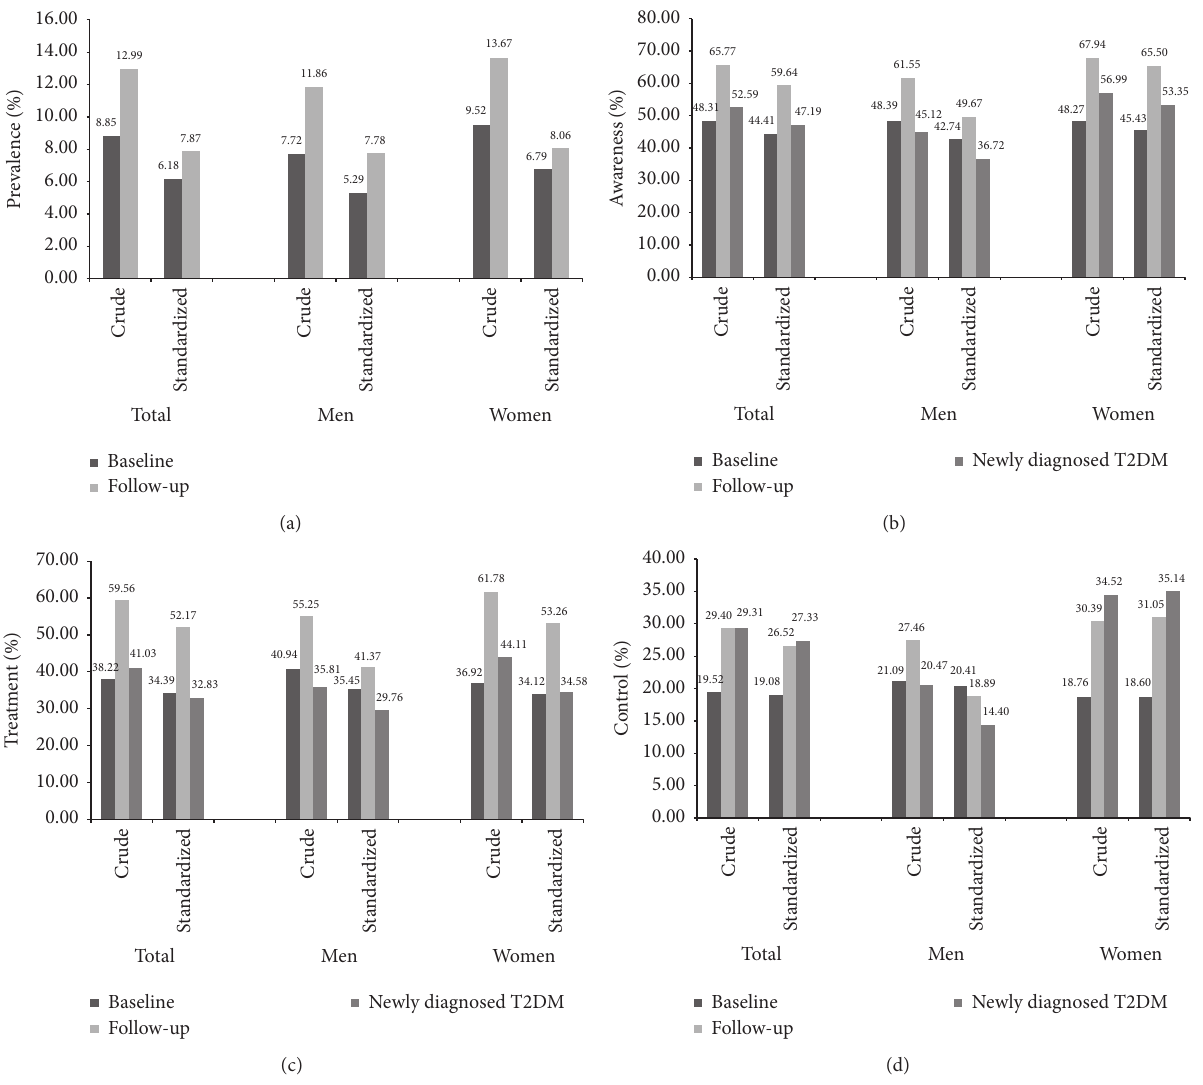
Figure 1: The crude and age-standardized prevalence (a), awareness (b), treatment (c), and control (d) of T2DM at baseline and follow-up for total, men, and women. (a) is for the prevalence of T2DM, (b) is for the awareness of T2DM, (c) is for the treatment of T2DM, and (d) is for the control of